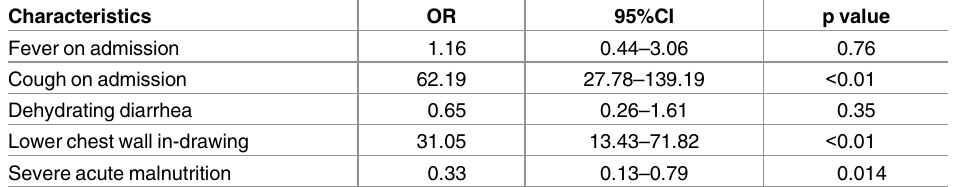
Table 2. Results of logistic regression analysis to explore the independent predicting factors of pneu- monia in diarrheal children having age specific fast